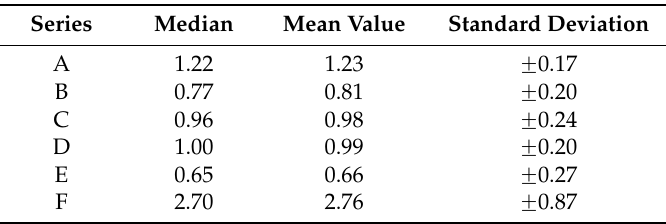
Table 3. Surface roughness of the primary crowns in original condition (measurement parameter: Rz ( µ m); measurement direction: vertical).